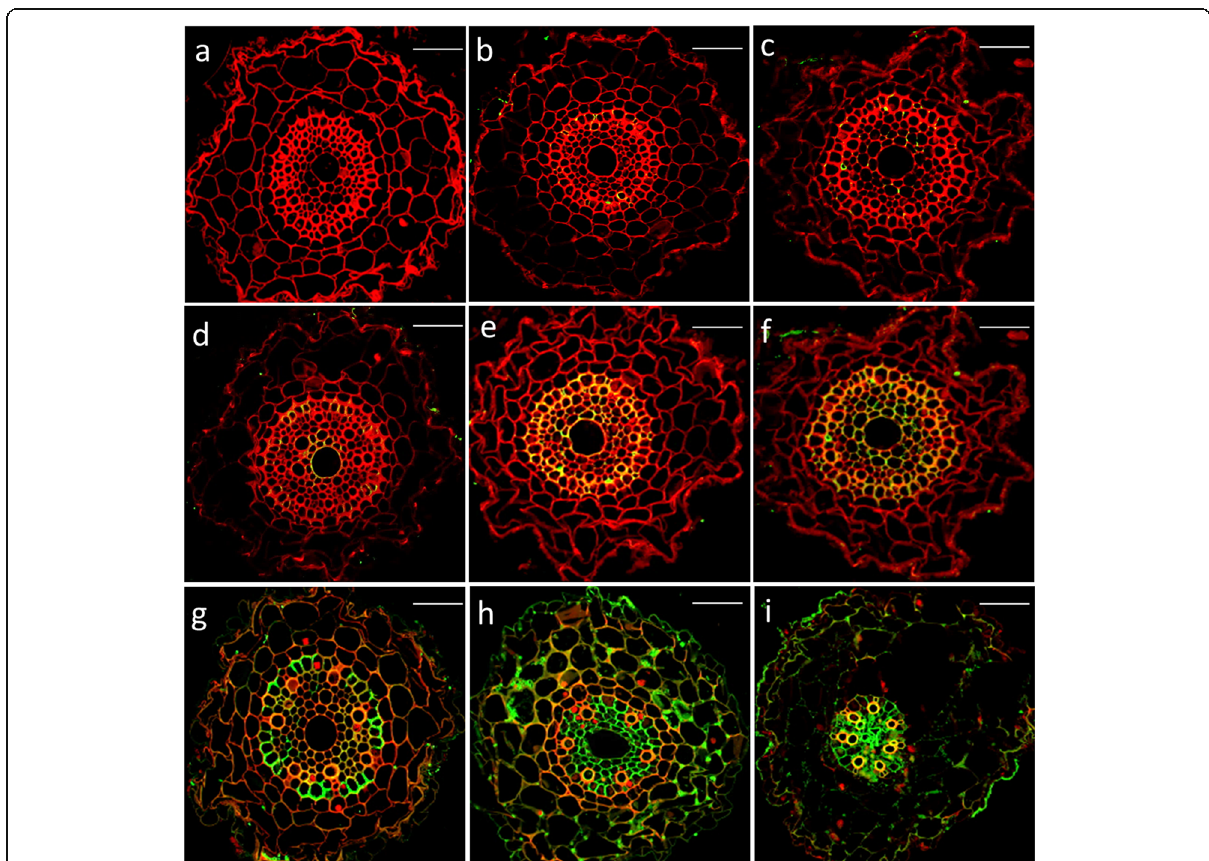
Fig. 2 Wheat roots infected by Gaeumannomyces graminis var. tritici were stained with WGA-AF488 and PI. a Control root at 5 dpi showing that root tissues were stained red. b - i Ggt -inoculated root showing that fungal hyphae were stained green at 1 dpi ( b ), 2 dpi ( c ), 3 dpi ( d ), 4 dpi ( e ), 5 dpi ( f ), 6 dpi ( g ), 7 dpi ( h ) and 8 dpi ( i ). Each bar represents 100 μ